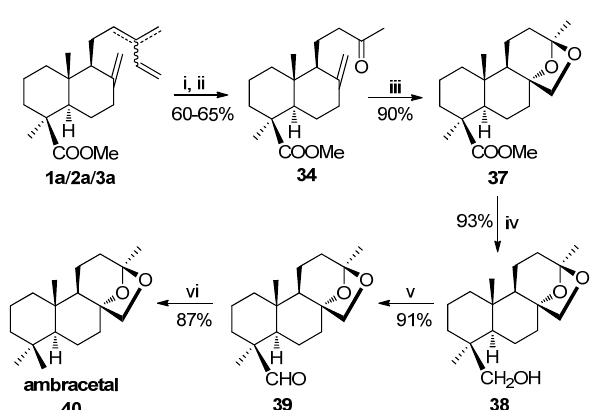
Scheme 10. Synthesis of